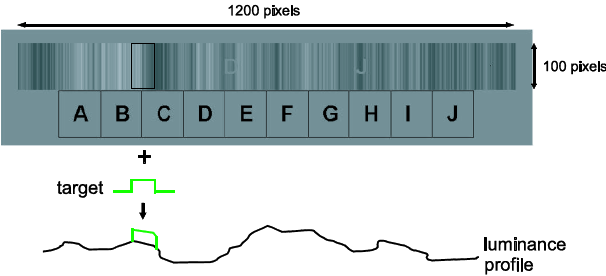
Figure 1. Letter search and identification task. The bar code (1200x100 pixels) represents a still image of a flickering noise movie whose (temporal and horizontal) frequency spectrum falls off with 1/f. Two letters are shown in the above display, both with high contrast for purposes of demonstration. Below the bar code, the letter menu is displayed, which is used for identification during visual search. A marker was generated by adding a rectangular function to the luminance profile of the bar code (bottom; profile not veridical to bar code). Ca. 6 randomly selected letters were shown per 10-second trial, each one for a duration of 500 ms at a contrast of 0.1 (not to scale in